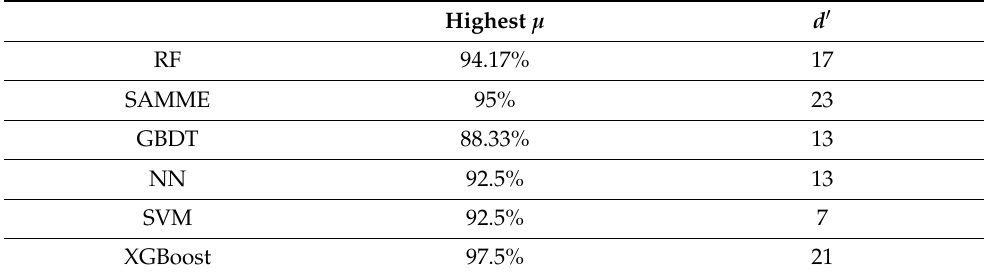
Table 3. The highest mean identification accuracies µ obtained on the test sets with the six classifica- tion methods, and the corresponding feature dimensions d (cid:48)